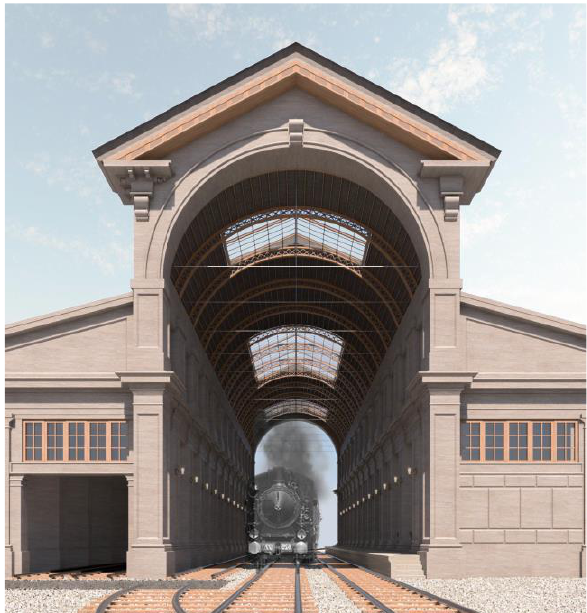
Figure 1. Reconstruction of the station of Perugia Fontivegge, by the architect Antonio